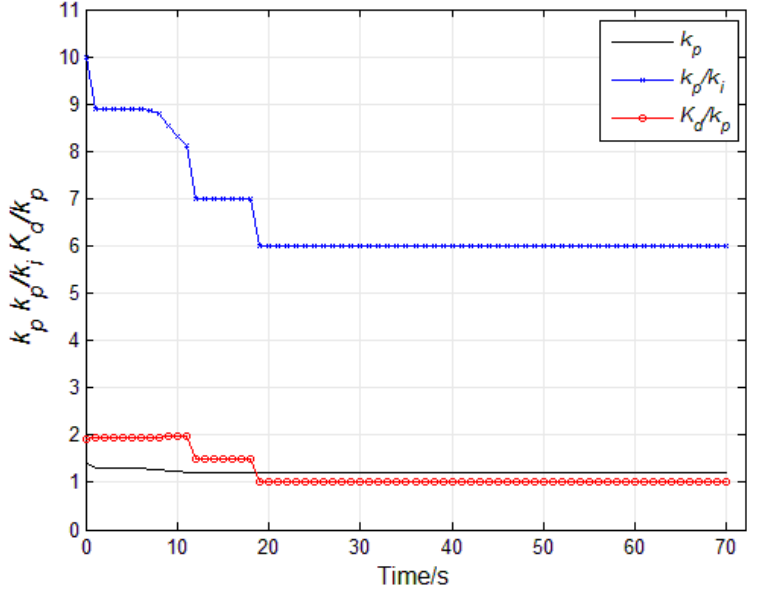
Figure 10. Online self ‐ regulation of PID parameters.